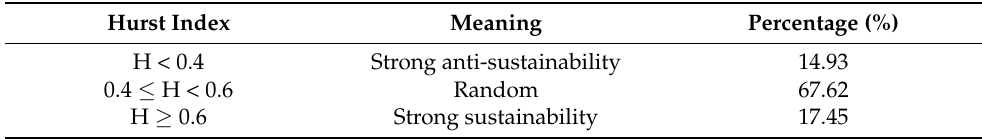
Table 2. Statistics of Hurst index of NDVI in Anhui Province.